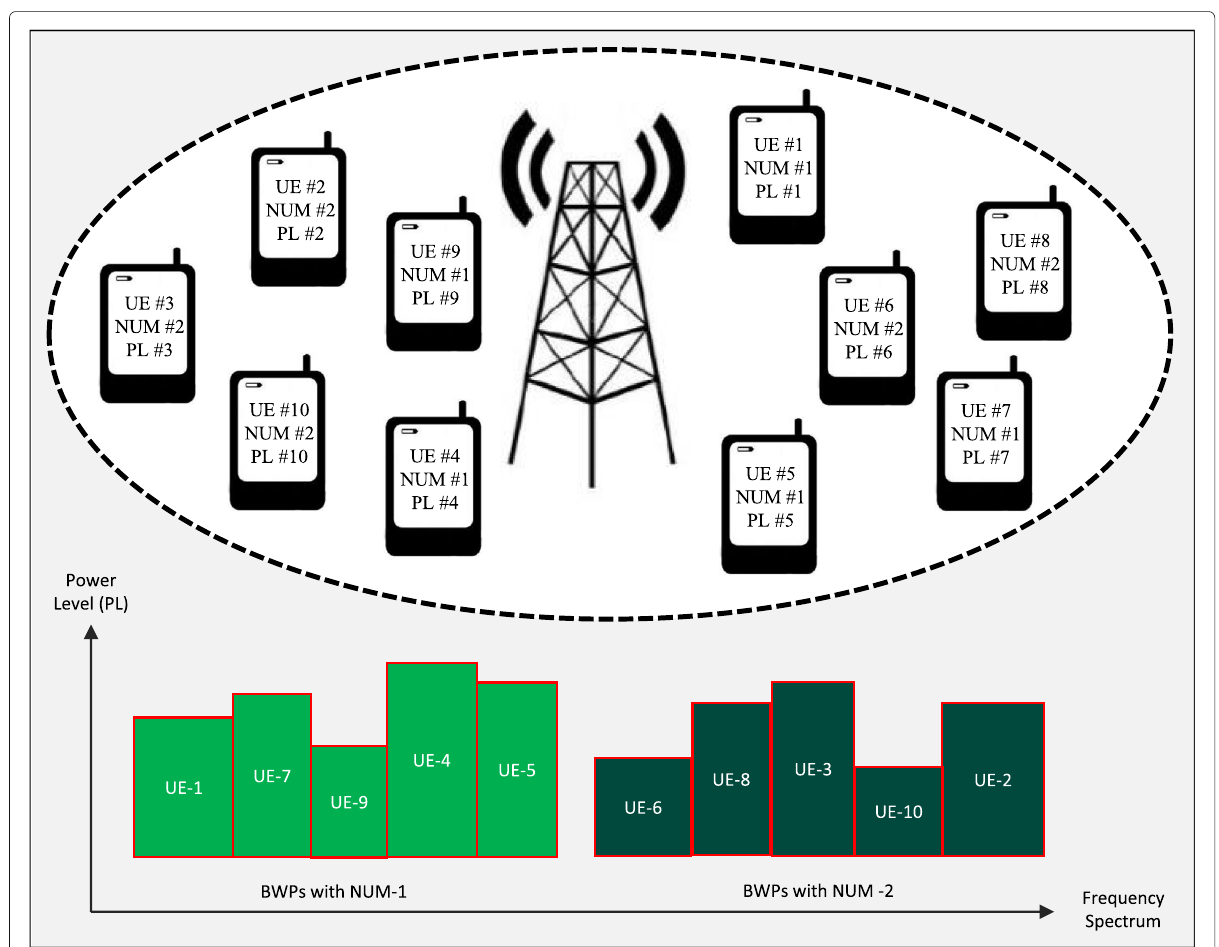
Fig. 1 An example resource allocation in frequency spectrum for the multiple numerologies (NUM) with different user PLs